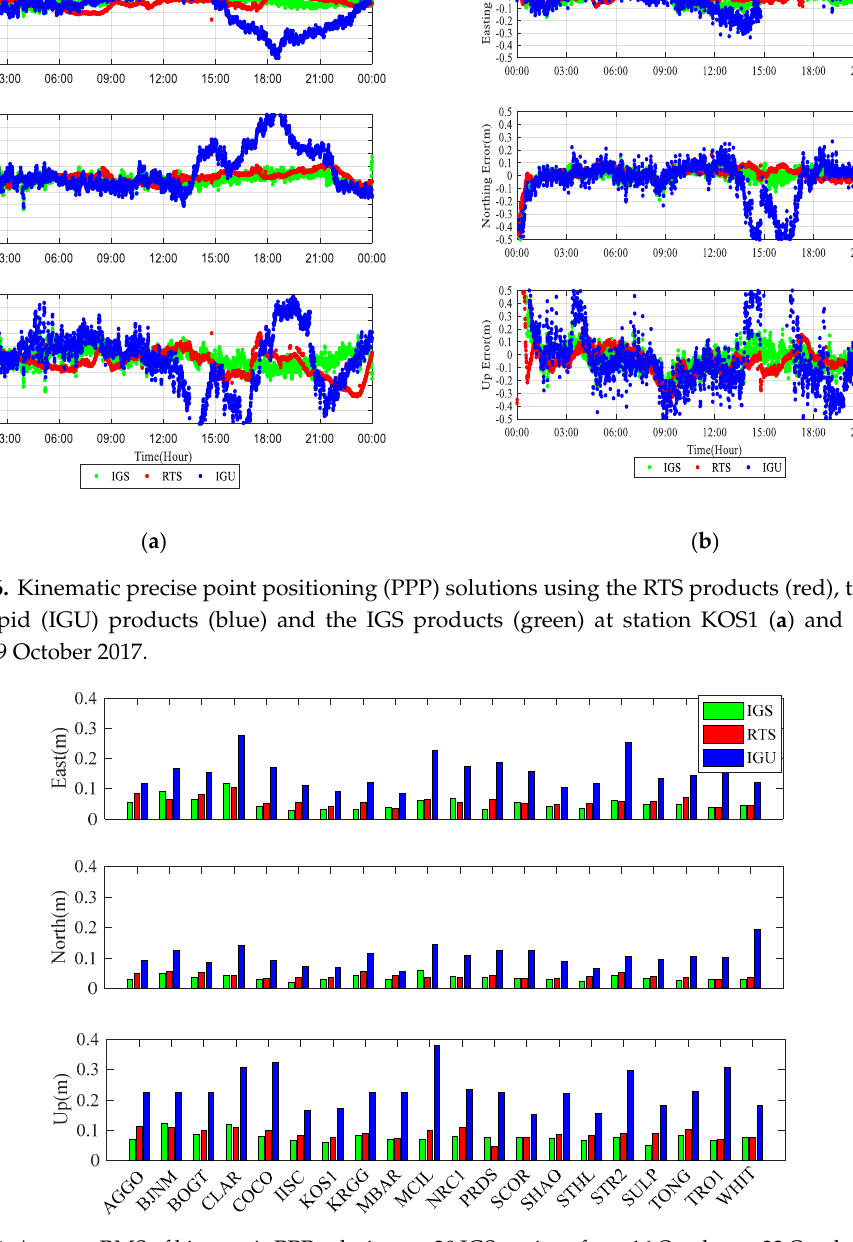
Figure 7. Average RMS of kinematic PPP solutions at 20 IGS stations from October 16 to October 22, 2017.